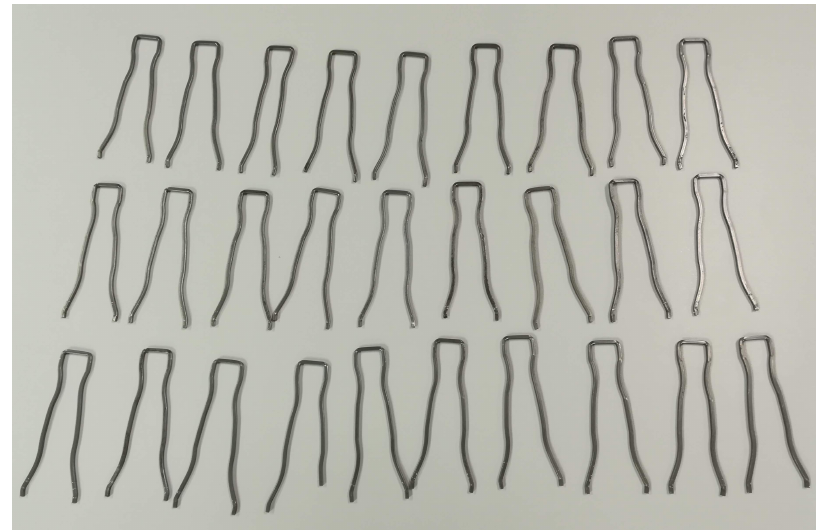
Figure 8. Set of objects used for the experiments with real data.